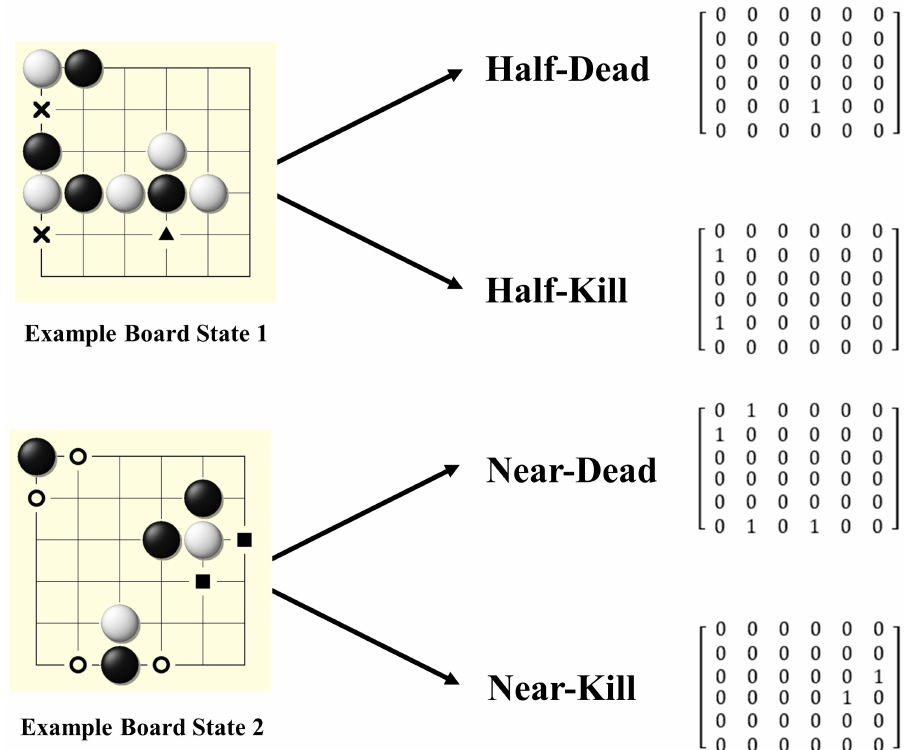
Figure 6. Demonstration of advanced features. Location of existing features is marked with one-hot encoding in the corresponding input layer. Four additional layers are added to the input layer set of the original AlphaZero and provide the NoGoZero+ agent with additional advanced information about the board state. Results in the next section show that such modification can obviously improve training speed and final